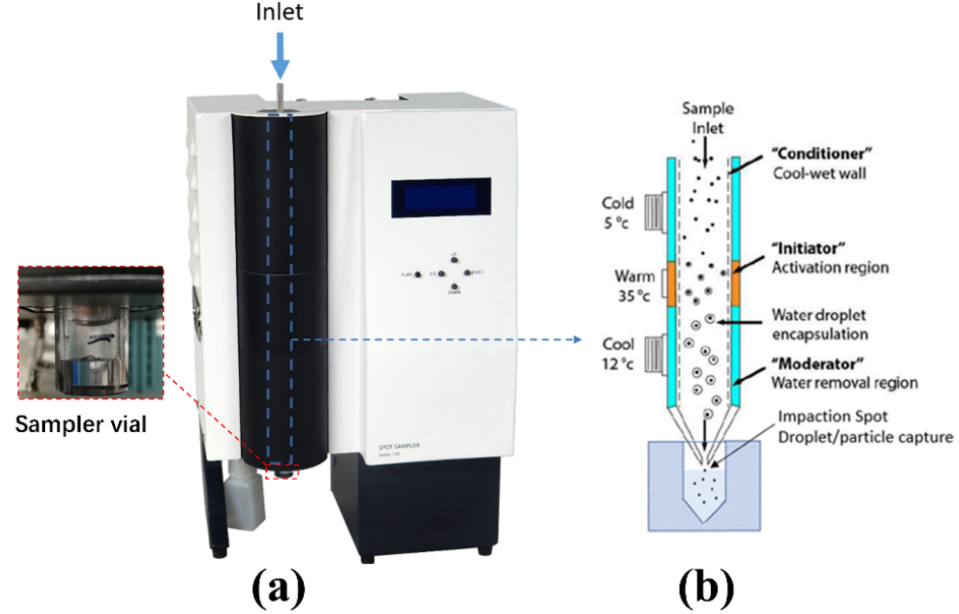
Figure 4. ( a ) Liquid Spot Sampler used for capturing SARS-CoV-2 virus, ( b ) capture mechanism of the Liquid Spot Sampler. The bio aerosol passed through the conditioner, initiator, and the moderator, grew to larger droplets, and was collected in the sampler vial through internal impaction.